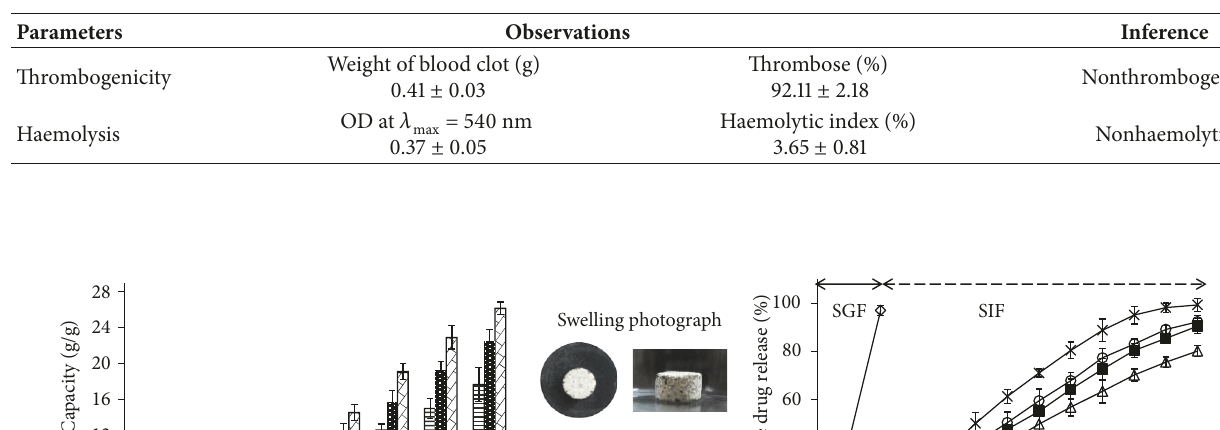
Table 4: Results of haemocompatibility studies of BSH.